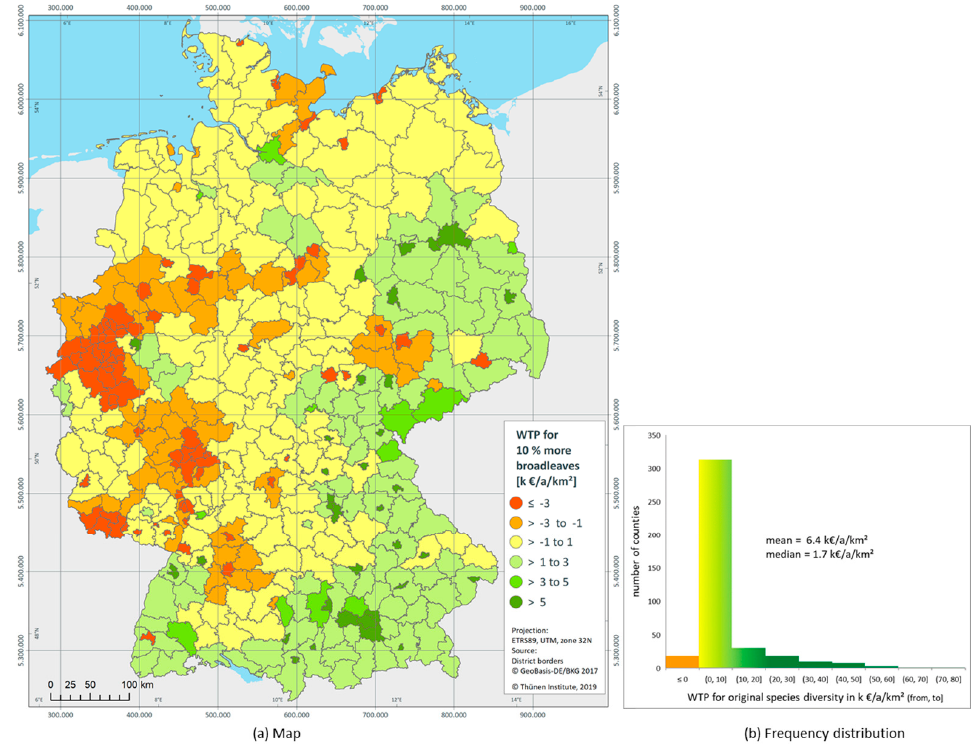
Figure 9. Annual benefits of increasing the share of deciduous trees by 10 percent points in the counties.